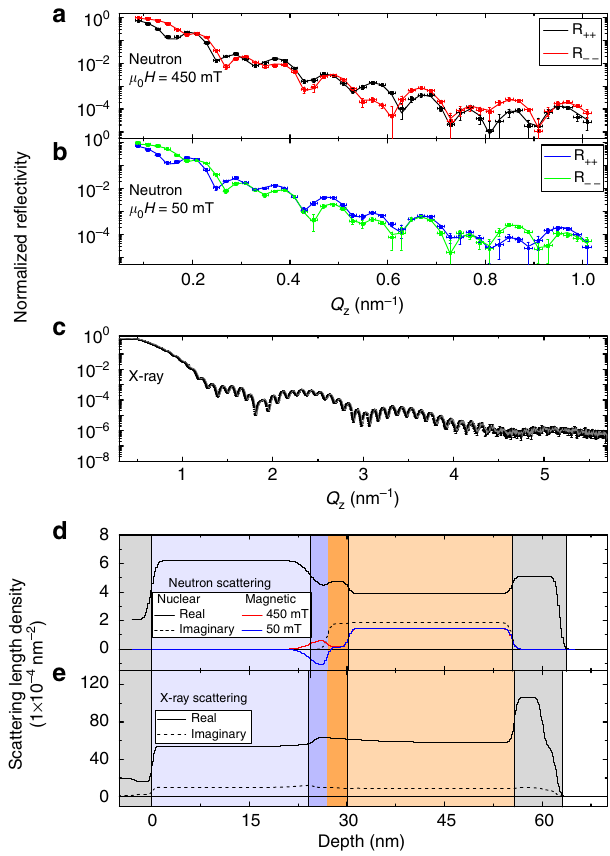
Figure 4 | Magnetic and structural depth profiles. PNR data (symbols) and fitted reflectometry (lines) for sample A ( x ¼ 0.42) in a ( a ) 450- and ( b ) 50-mT field applied parallel to the cooling field; ( c ) X-ray reflectometry data (symbols) and fitted reflectometry (line) of sample A. ( d ) The fitted profile determined from PNR with the real (solid) and imaginary (dashed) nuclear structure shown in black and magnetic depth profile in blue (50mT) and red (450mT); the structural profile from X-ray reflectivity (XRR) is shown in e . For d and e , the film structure from the left to right, at increasing depth, corresponds to the Si substrate (grey), NiCoO (light blue), interfacial NiCo (dark blue), interfacial GdFe/GdO y (peach), GdFe (brown), Ta cap (grey) and air (white). Error bars in Q z identify machine precision; error bars in normalized reflectivity are defined by the s.d. and scales with the square root of the number of not contain Gd and can be attributed to elemental NiCo. The magnetic depth profiles measured in 450 and 50 mT (Fig. 4d) show that the magnetic moment drops across the GdFe/NiCoO interface to zero in the NiCoO layer. For the 450 and 50 mT measurements, the interfacial magnetization is parallel and antiparallel to the GdFe layer magnetization, respectively. This difference corresponds to the transition between stages f and g in Fig. 3, which through XMCD was shown to originate from rotatable NiCo. This last piece of evidence shows that the NiCo responsible for phase 2 (Fig. 1) is indeed located at the interface and is probably the result of oxygen migration from NiCoO to GdFe. For comparison, the X-ray reflectivity spectrum—which is insensitive to magnetic ordering—is shown in Fig. 4c. The structural depth profile determined by X-ray reflectivity in Fig. 4e has features that track those in the PNR depth profile, especially the thicknesses, and shows a slight peak in the scattering length density at the GdFe/NiCoO interface, serving as another confirmation of the structural profile.